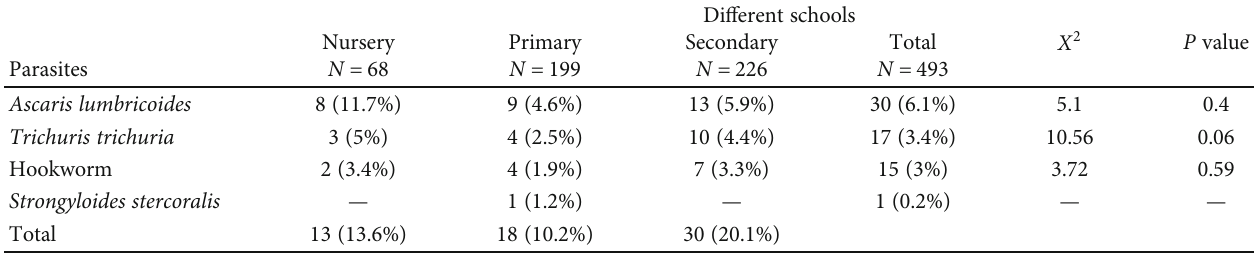
Table 5: The prevalence of parasitic helminths among schools.